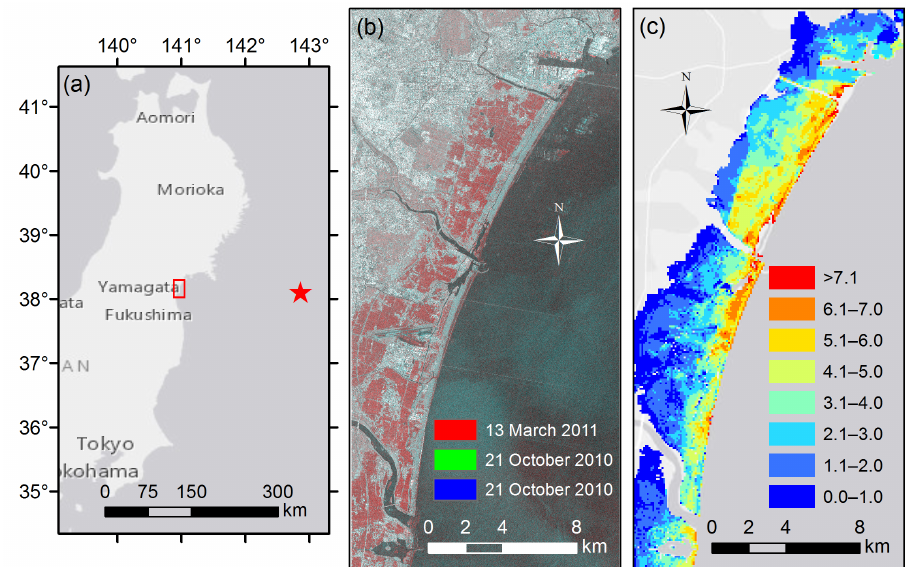
Figure 2. Study area. ( a ) Location of the coastal area of Miyagi Prefecture (red rectangle) within the Tohoku region of Japan; ( b ) RGB color composite of the TerraSAR-X images acquired on 13 March 2011 (red) and 21 October 2010 (green and blue); ( c ) Inundation depth map of the Great East Japan Earthquake and Tsunami. The inundation values are given in units of meters.